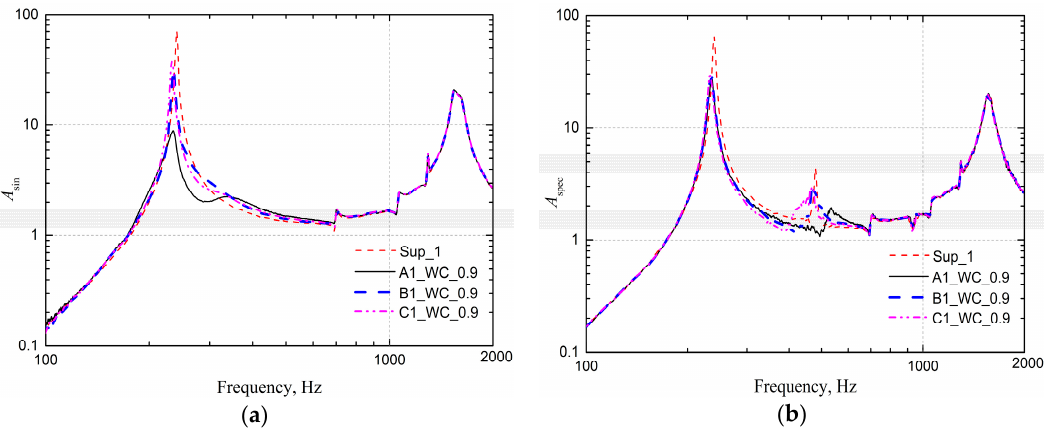
Figure 9. Experiment results of Tungsten carbide powder (layering in Z-direction of the cavity); ( a ) Sinusoidal excitation; ( b ) Random excitation.